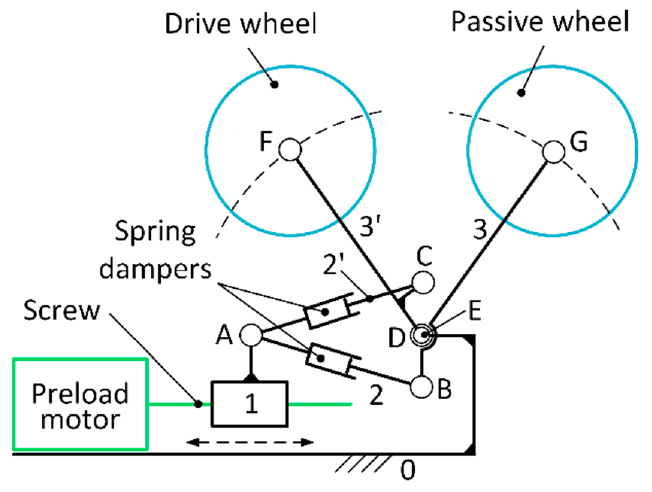
Figure 7. Adapting mechanism with dampers.